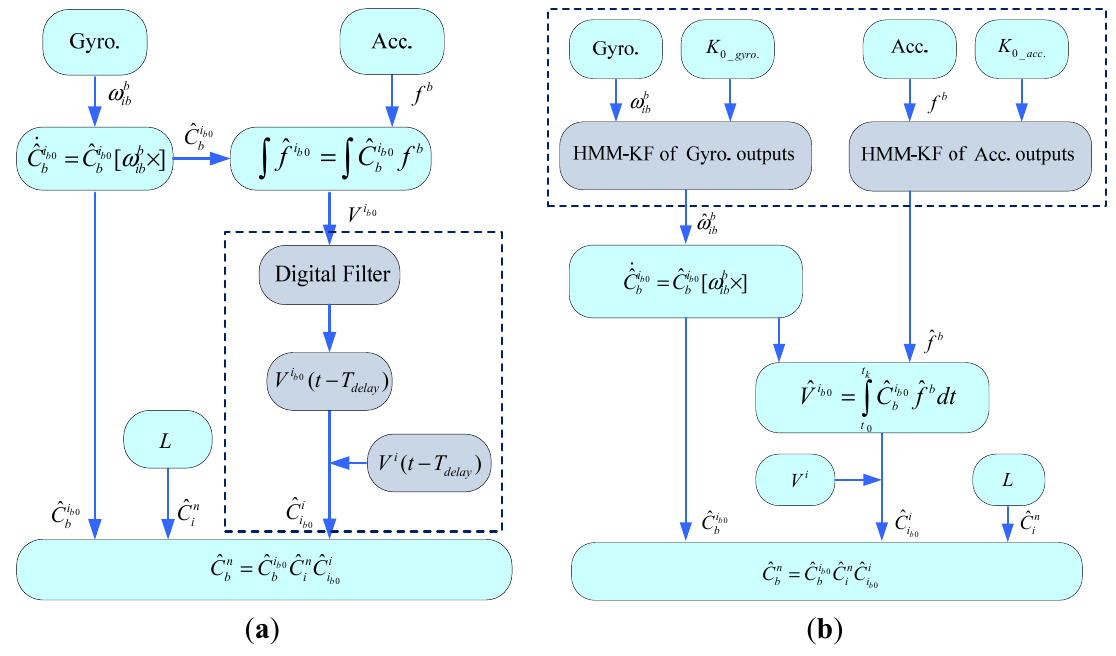
Figure 11. Flowcharts of the digital filter aided and the HMM-KF aided inertial frame based alignment mechanisms. ( a ) Digital filter aided; ( b ) HMM-KF